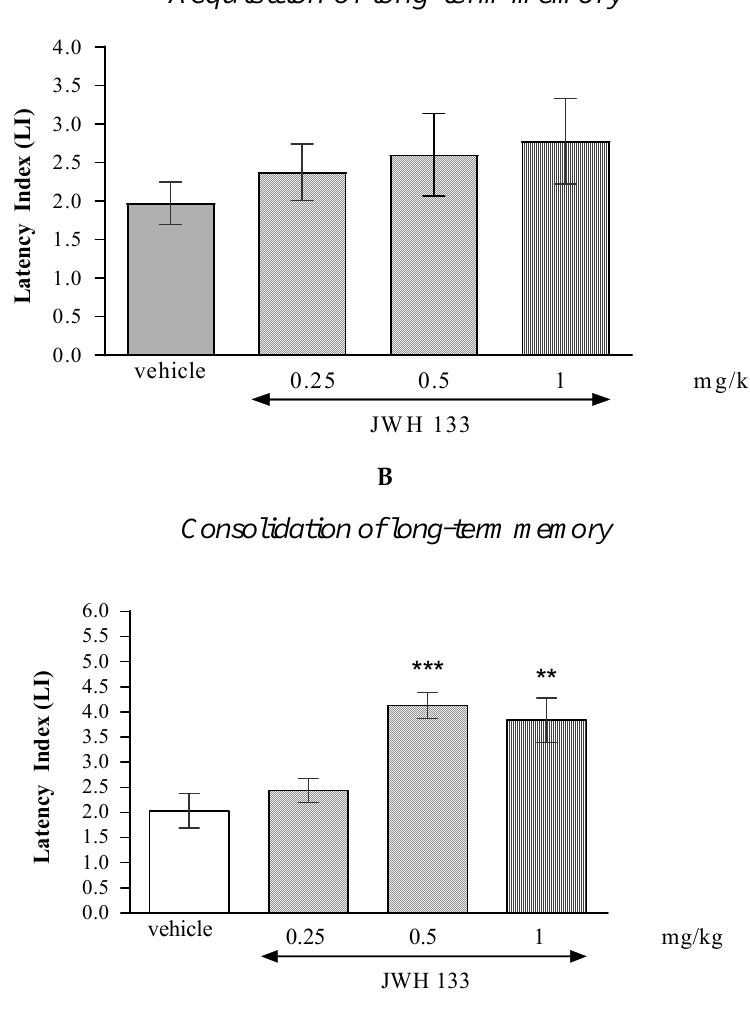
Figure 2. The influence of an acute administration of JWH 133 on the cognition ‐ related responses, expressed as latency index (LI), during the acquisition ( A ) and consolidation ( B ) of memory using the PA test in mice. JWH 133 (0.25, 0.5 or 1 mg/kg) or vehicle were administered 30 min before the first trial (acquisition of memory) or immediately after the first trial (consolidation of memory). The second trial was conducted 24 h after the first one; n = 8–10; the means ± SEM; ** p < 0.01; *** p < 0.001 vs. vehicle ‐ treated group; Tukey’s test.